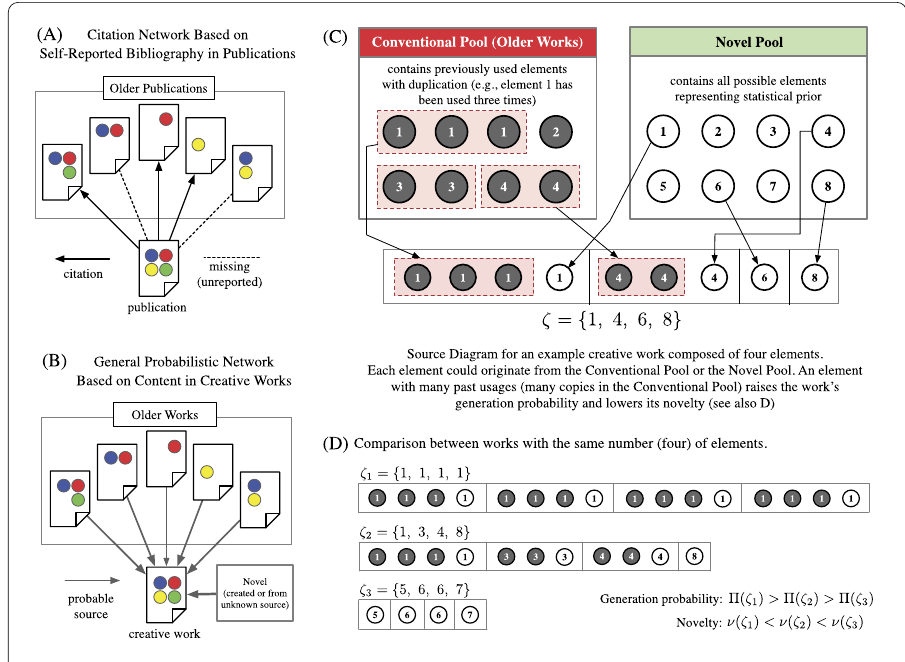
Figure 1 Reference and Information Network formalism for Novelty of Creative Works. ( A ) A citation network for publications relies on self-reported bibliography connecting a new work to older works (solid arrows). Various factors as human error and bias may cause missing links (dotted), indicating loss of information. ( B ) A general probabilistic network is constructed by connecting two works that share a common element that represents a probabilistic reference. Unlike a citation network, therefore, no known source is omitted due to error or bias. Furthermore, since an element can be truly invented or come from unknown sources, the Novel Pool (statistical prior) is also considered. ( C ) Calculating the generation probability of a creative work given past works. The generation process is modeled as choosing elements from the Conventional Pool (CP) that contains previous used elements (with duplication, so that often used elements are common in the CP as well) or from the Novel Pool (NP) that represents ‘inventing’ the element or referencing an unknown source. Setting NP to contain a fixed number of each possible element corresponds to the Maximum A Priori estimator and additive Laplace smoothing, Eq. (6). The probability of choosing an element is proportional to its multiplicity in the combined pool. Consider an example work of length four, ζ = { 1,4,6,8 } . Here element 1 is the most common (four copies total, three from CP and one from NP), whereas 6 and 8 are the least so (one from NP only). The total number of those elements in the pool represent the generation probability of ζ